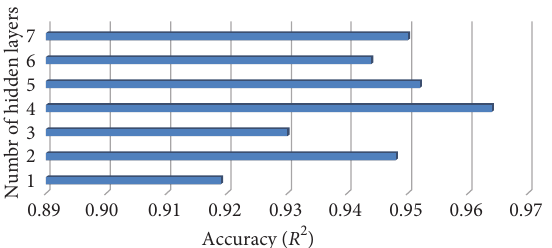
Figure 3: Performance of several MLP architectures with the purpose of picking the optimal one with the maximum accuracy ((R) 2 ), where the best corresponding models are presented in Table 6.